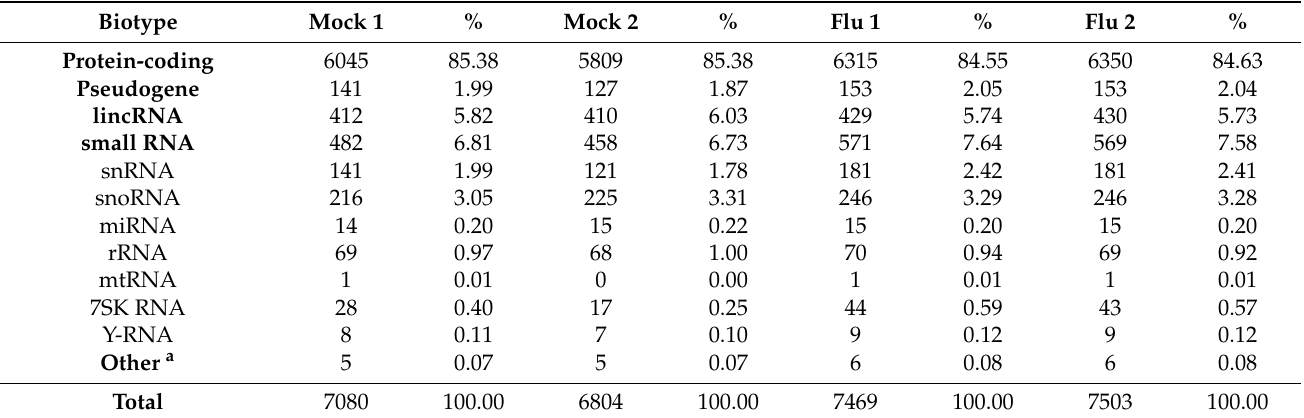
Table 2. Total number of Canis lupus familiaris (CanFam3.1, GCA_000002285.2)–specific reads repre- senting different biotypes.